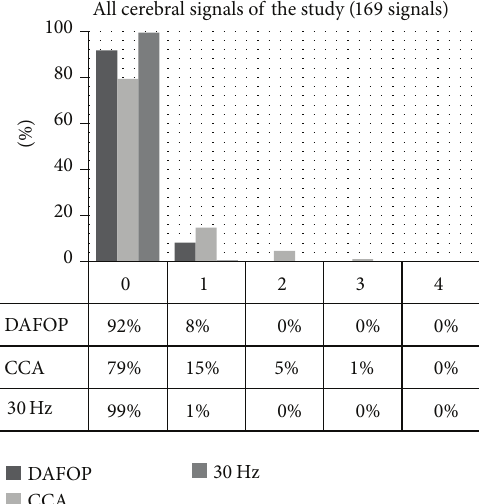
Figure 6: Amount of removed cerebral signals per 20 s page (0: no difference ( < 10%); 1: ( 10 – 35 %); 2: ( 35 – 65 %); 3: ( > 65–90%); 4: no longer identifiable ( > 90%). For example, the table can be read as follows: among the 71 pages with an alpha rhythm, the experts noticed no significant difference in the alpha signals on 96% of